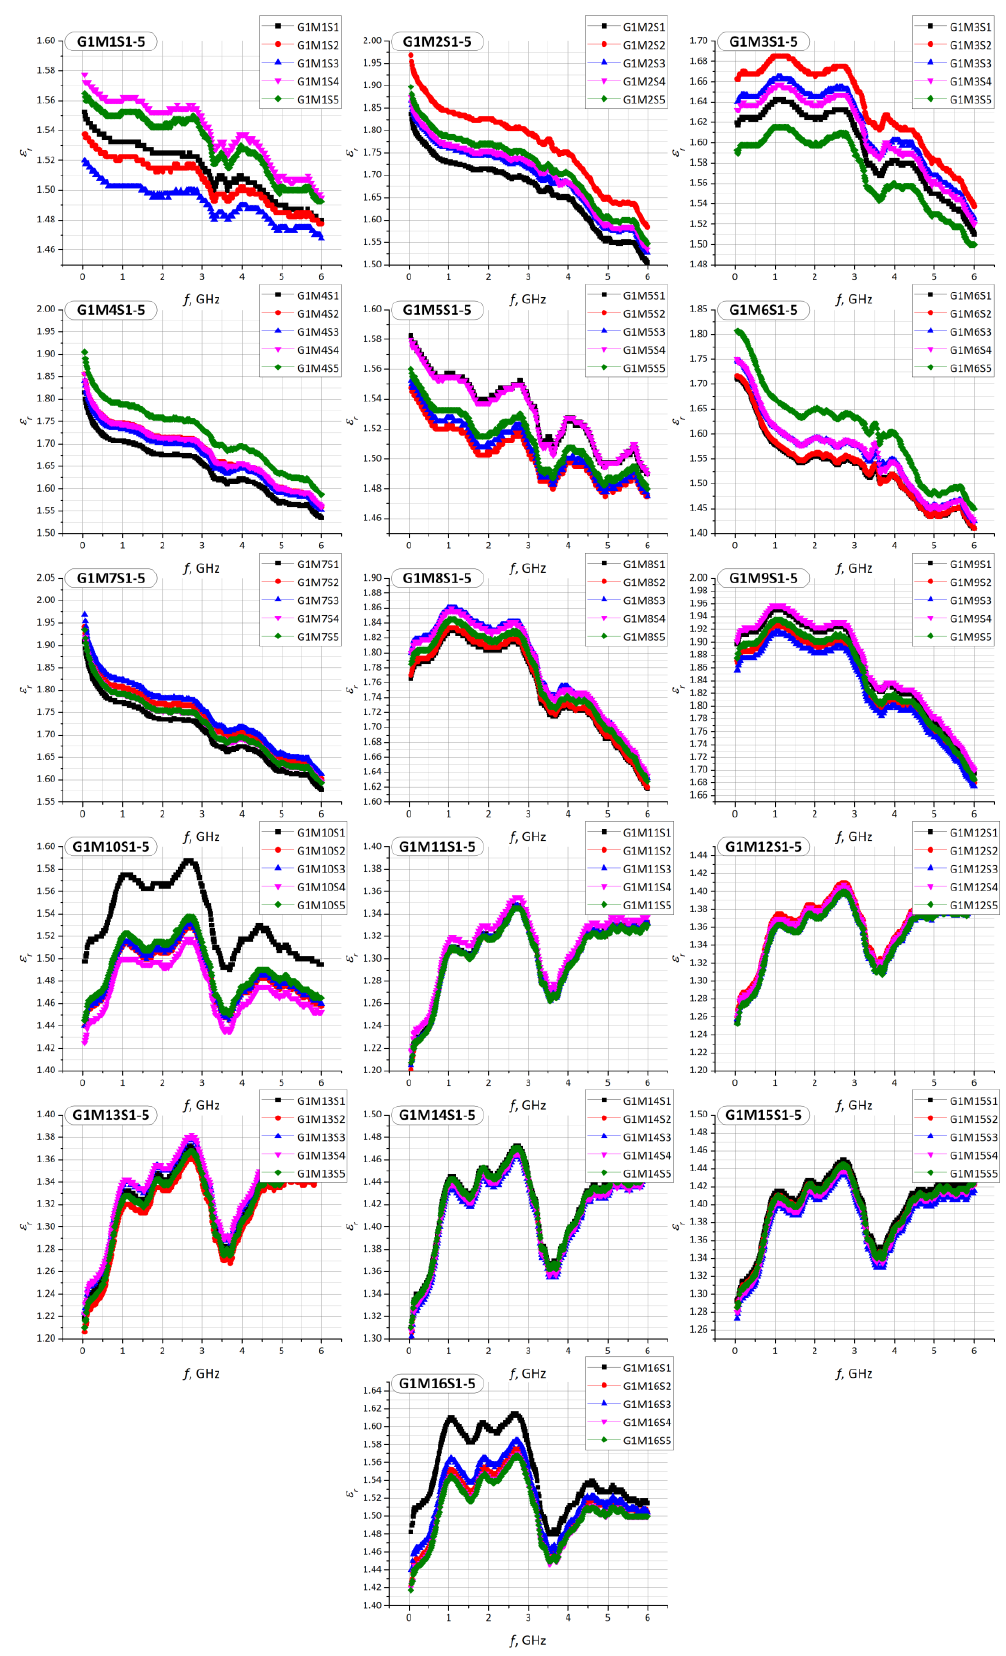
Figure 11. Results of ε r measurements for every sample of S1 – S5 in G1 (G1M1S z – G1M16S z ) group.